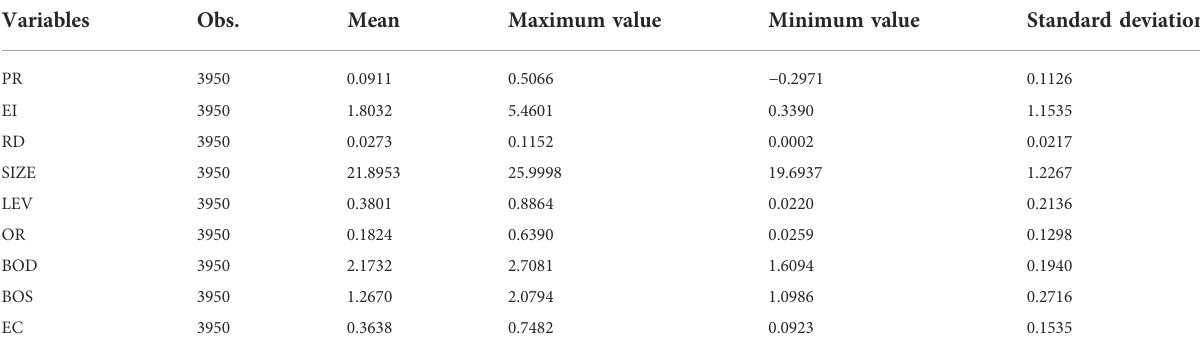
TABLE 1 Descriptive statistics of the variables.